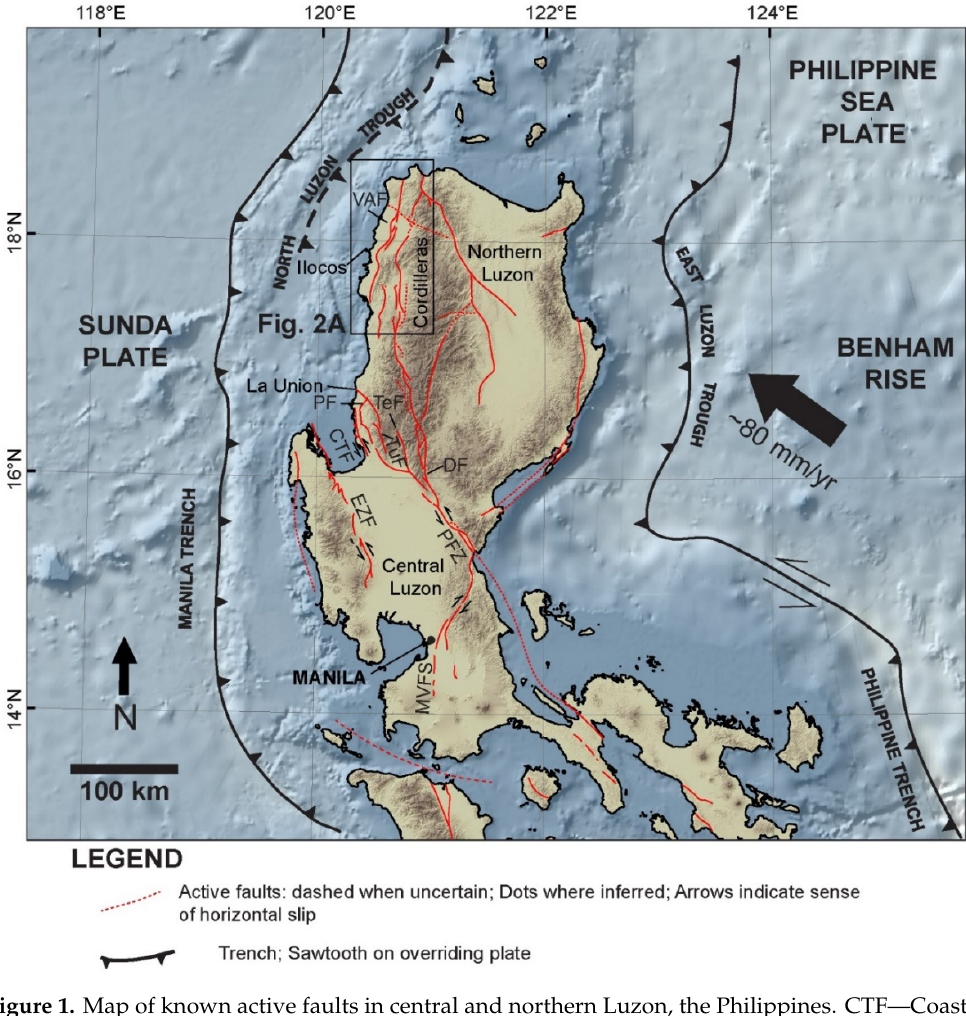
Figure 1. Map of known active faults in central and northern Luzon, the Philippines. CTF—Coastal Thrust Fault, PFZ—Philippine Fault Zone, VAF—Vigan-Aggao Fault, PF—Pugo Fault, TeF—Tebbo Fault, TuF—Tuba Fault, DF—Digdig Fault, EZF—East Zambales Fault, and MVFS—Marikina Valley Fault System.